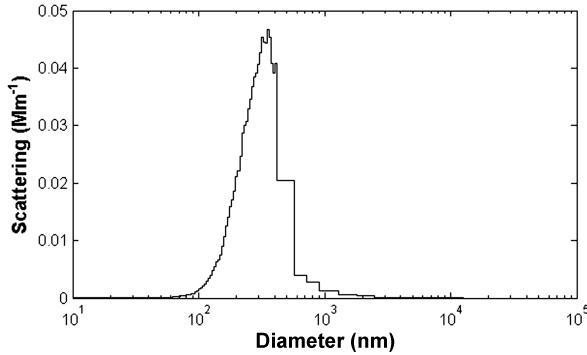
Figure A2. Scattering coefficient from Mie calculation according to each bin of the particle size